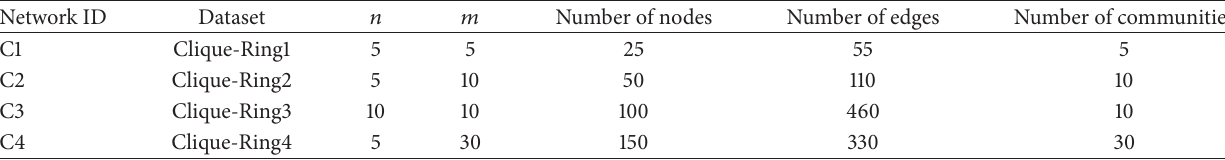
Table 1: The parameters of four Clique-Ring networks.